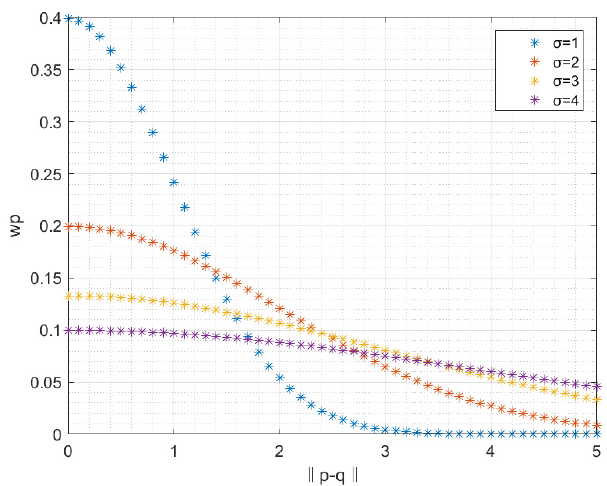
Figure 2. The effect of different spatial distance || p − q || on weight w p . For instance, the distances from the eight surrounding pixels to the target pixel are in √ √ √ √ order 5, 2, 5, 2, 1, 2, 1, and 1 from left to right and from top to bottom in the negative x-direction mask, respectively; and the distances from the eight surrounding pixels to the √ √ √ √ target pixel are in order 2, 5, 2 2, 1, 2, 5, 1, and 2 from left to right and from top to bottom in the bottom-right diagonal mask, respectively. Suppose variable d denotes